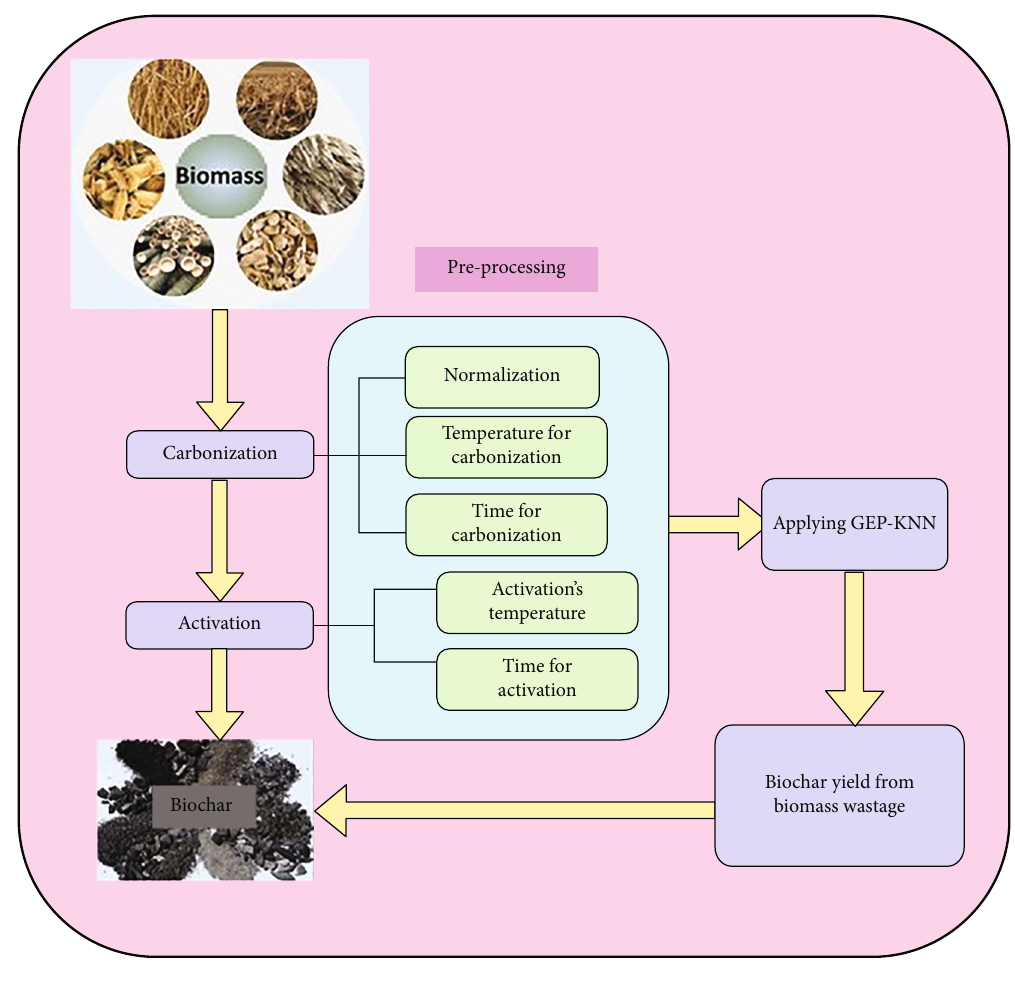
Figure 1: Architecture of proposed